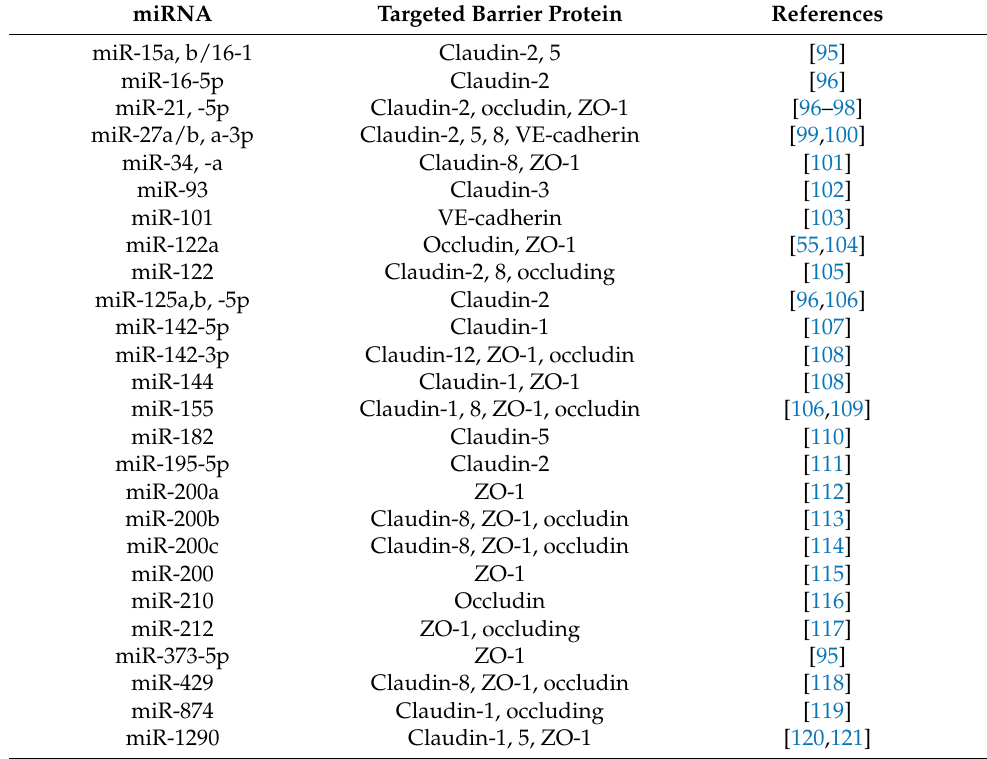
Table 4. miRNA-regulated barrier